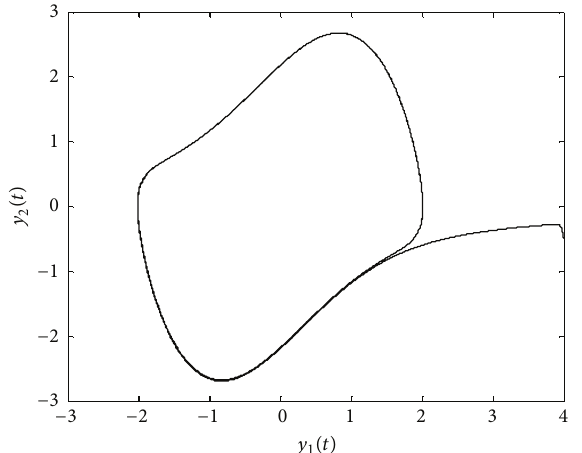
Figure 7: Phase portrait of the Van der Pol equation.